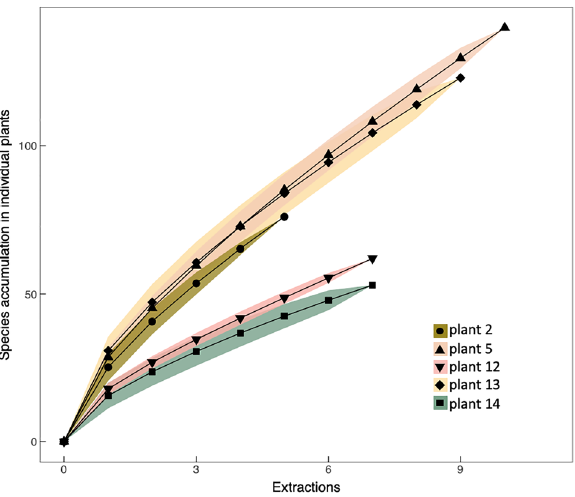
Figure 5. Species accumulation curves for foliar fungal endophytes colonizing milkweed ( Asclepias speciosa ). Each curve represents the SVs recovered from a single plant through additional extractions of bulk material (6 leaves per plant divided into ~ 250 mg extractions).